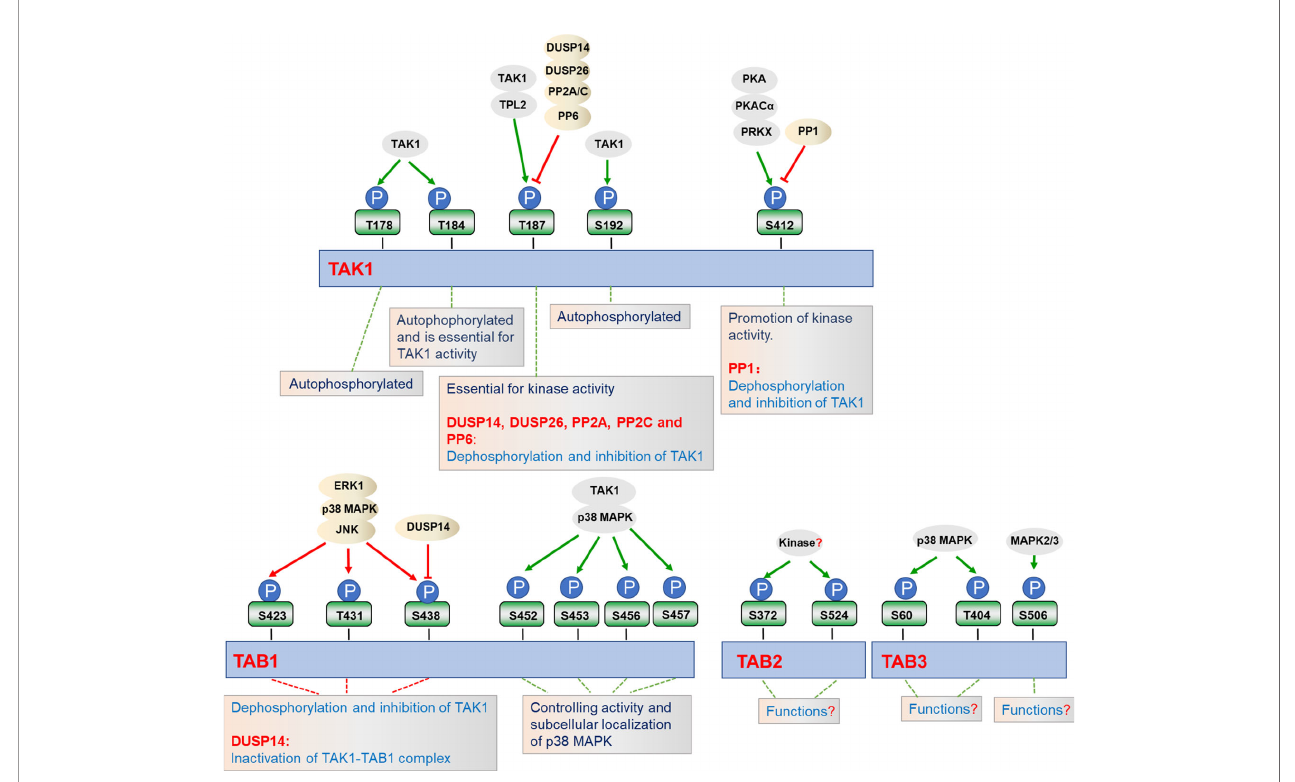
FIGURE 2 | Regulation of TAK1-TABs complex by phosphorylation. TAK1-TABs complex is heavily and dynamically modi fi ed with phosphorylation (P) and dephosphorylation by the indicated kinases or phosphatases, which regulates their activity and subcellular